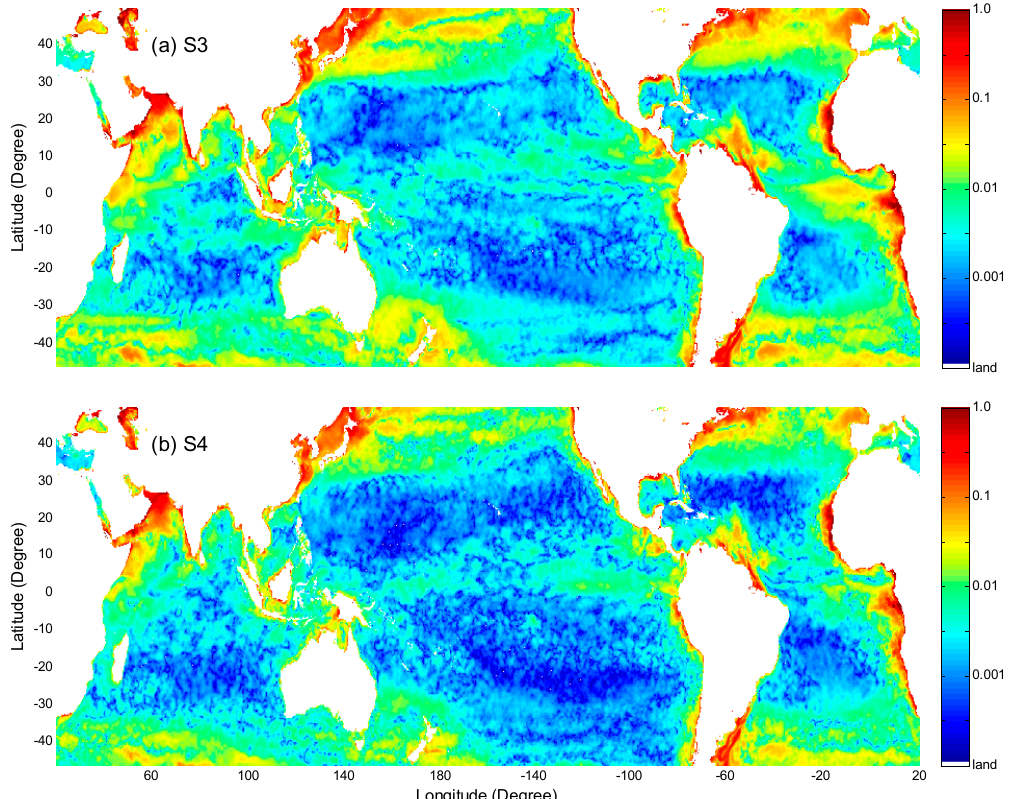
Figure 4. The amplitude images of three-cycle ( a ) and four-cycle ( b ) fitted from Equation (3) in the unit of mg/m 3 .